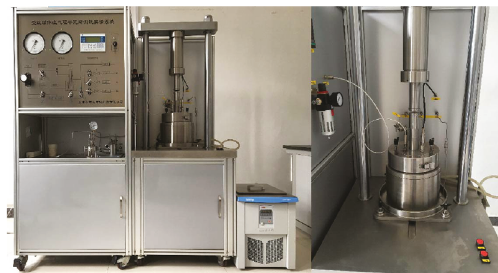
Figure 2: The gas fl ow and displacement testing